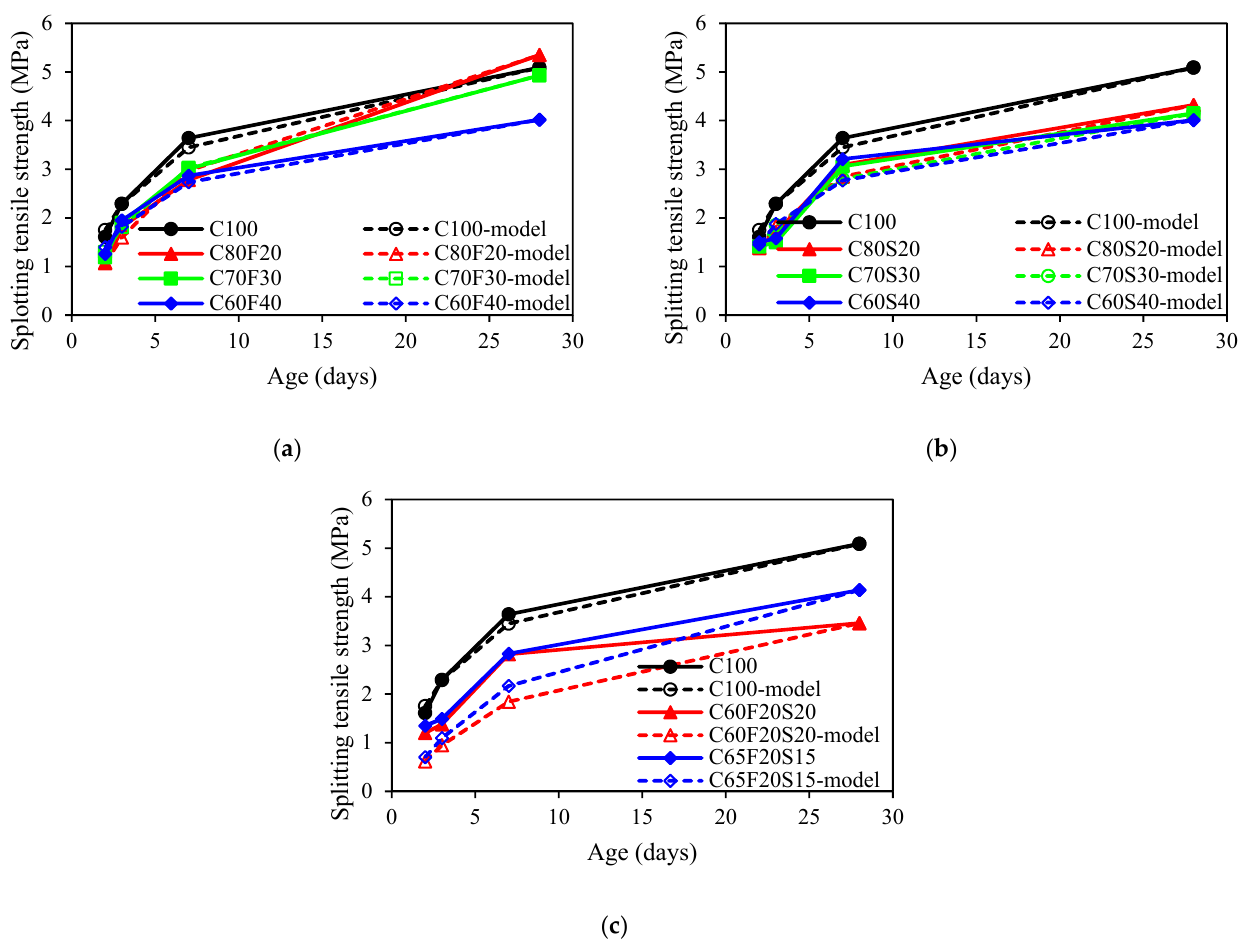
Figure 13. Comparison between experimental data and predicted splitting tensile strength using proposed models for s 2 : ( a ) fly ash group; ( b ) GGBFS group; ( c ) ternary binder group.